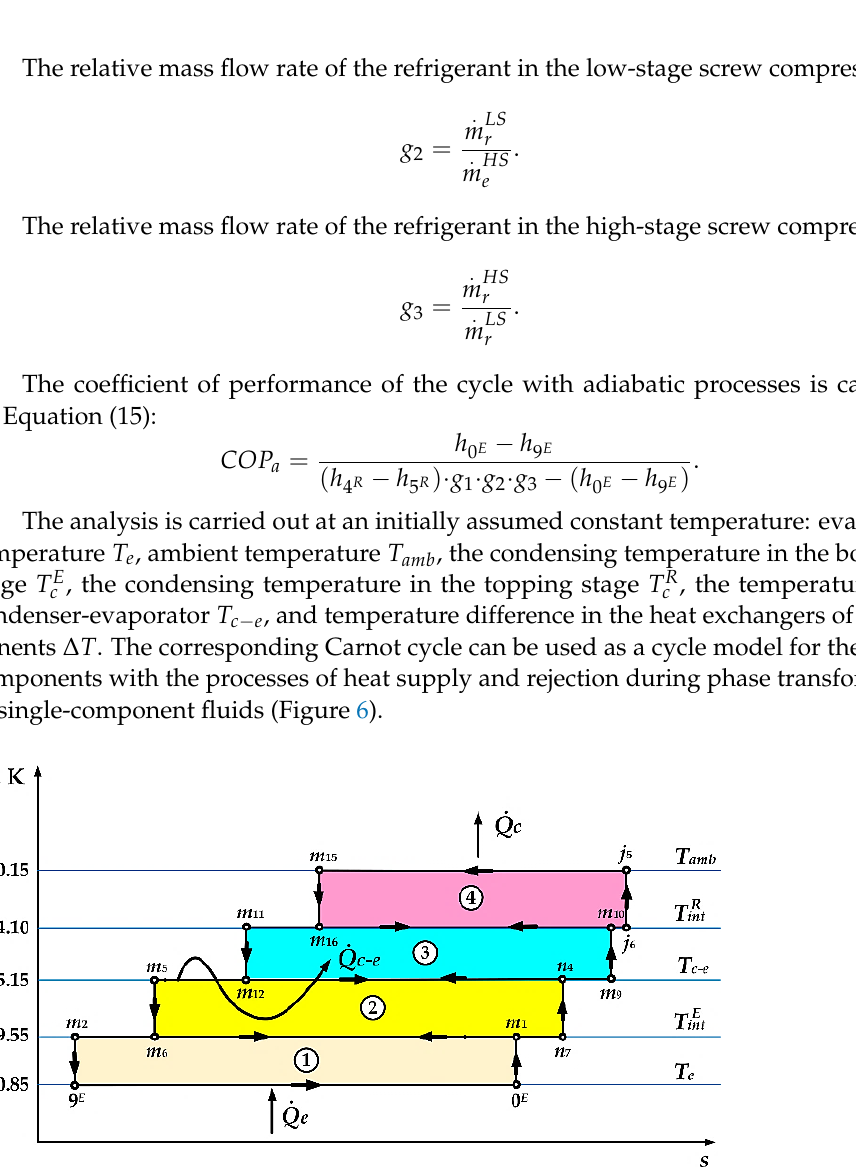
Figure 6. Cycle model of the cascade refrigeration system in the T – s diagram.